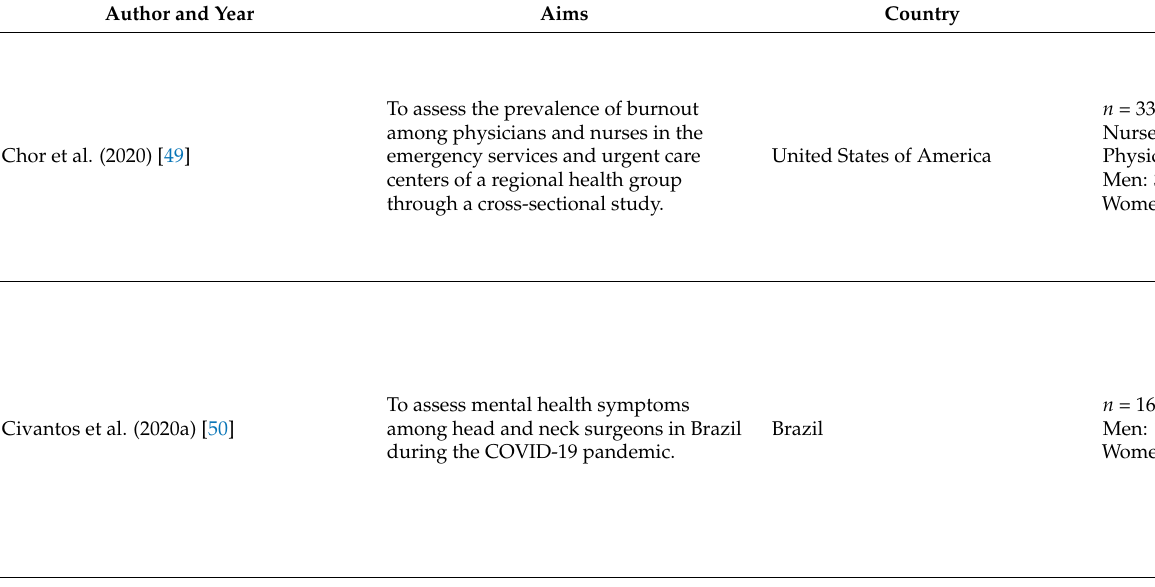
n = 163 head and neck surgeons Men: 121 Women: